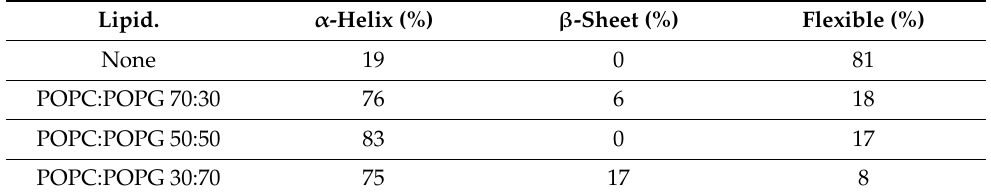
Table 2. Secondary structure content calculated from CD spectra of NAPHT-BP100 in solution and bound to LUV. Lipid. α -Helix (%) β -Sheet (%)